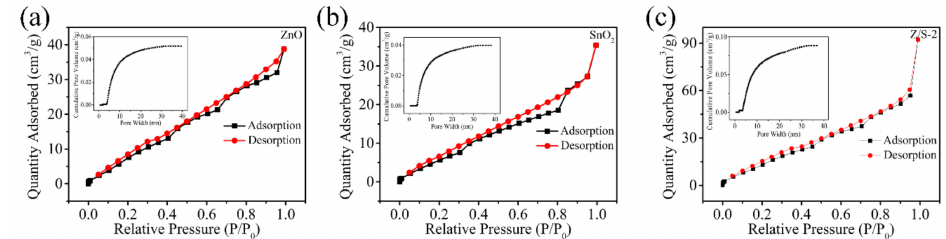
Figure 8. N 2 adsorption-desorption isotherms and pore diameter distribution of the ( a ) ZnO, ( b ) SnO 2, and ( c ) Z/S-2